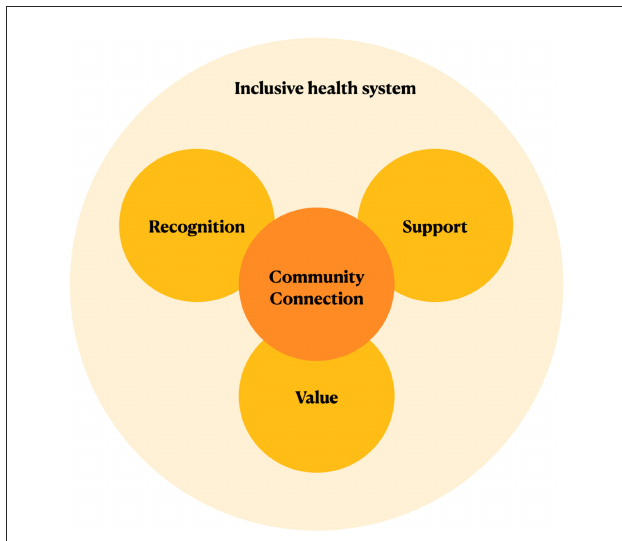
FIGURE5 Five categories of change to ensure AHW sustainability. This figure summarizes the five categories of change for AHW sustainability emphasized by our yarns, with “Community Connection” central, and an ‘Inclusive health system’ overarching.